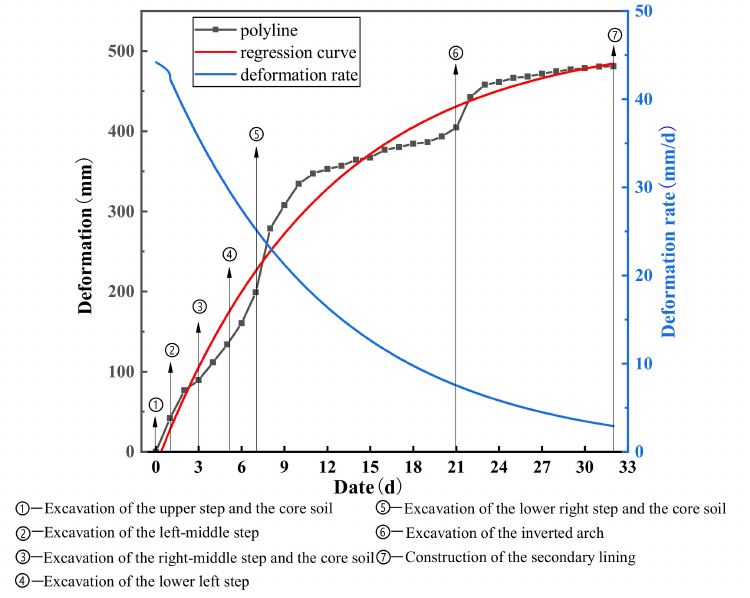
Figure 20. Deformation analysis diagram of the vault of the YK280+220 section of the